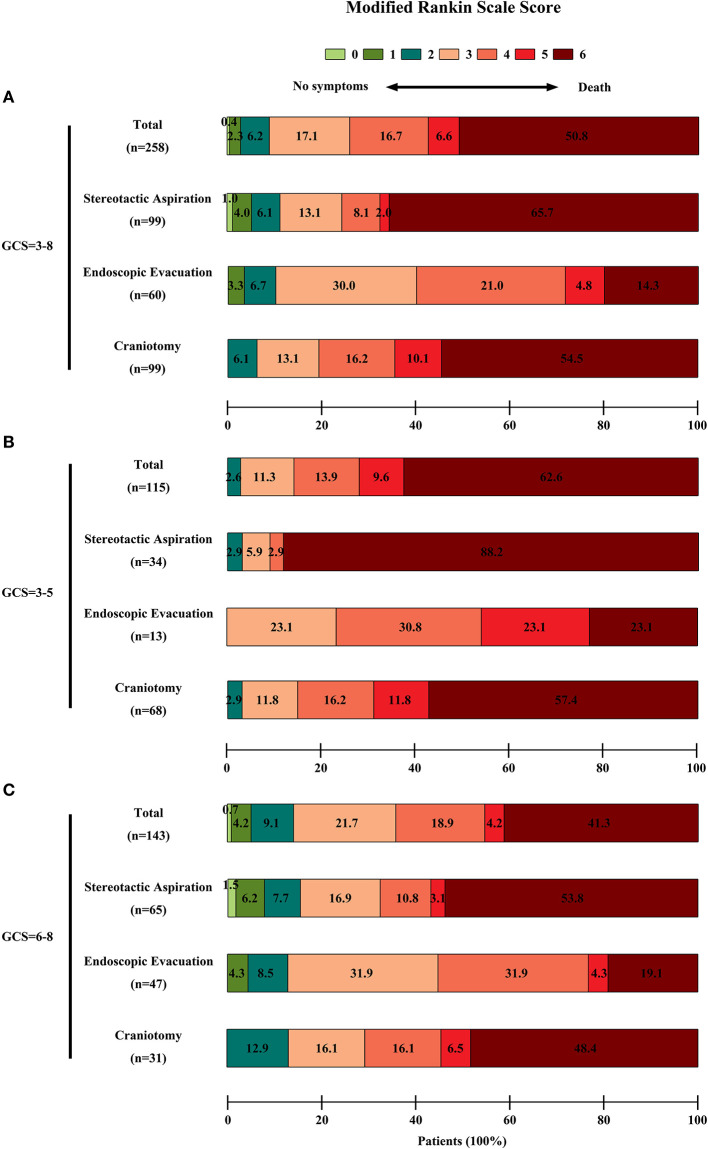
Functional outcome of patients in each group. The functional outcome was assessed by the mRS score. The scores ranged from 0 to 6, with 0 indicating no symptoms; 1, no clinically significant disability; 2, slight disability; 3, moderate disability; 4, moderately severe disability; 5, severe disability; and 6, death. A score of 3–5 was recognized as a poor outcome. The percentages of patients by score are shown in each cell. (A) The mRS scores of the entire cohort of patients. There were significant differences among the three groups on univariate analysis in the 6-month clinical outcomes (P < 0.0001 for the mortality, P = 0.0390 for low mRS score in surviving patients). (B) The mRS scores of patients with an initial GCS score = 3–5. (C) The mRS scores of patients with an initial GCS score = 6–8.